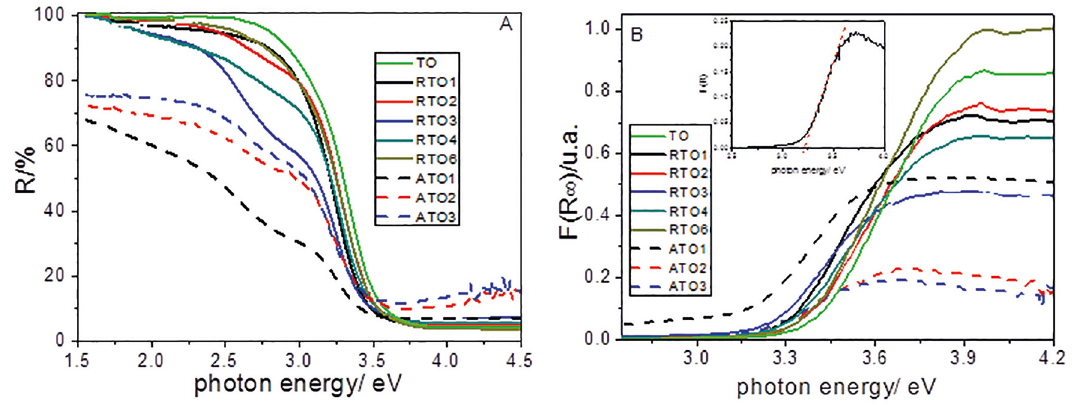
Figure 5. UV-vis diffusive reflectance spectra (A) and Kubelka Munk function (B) for the different